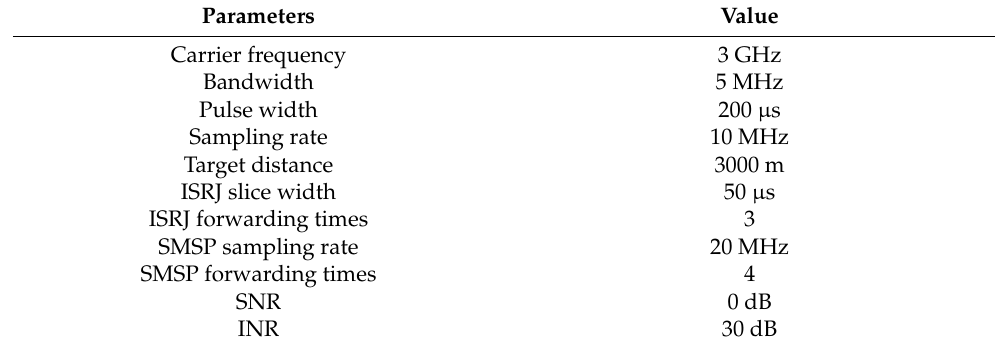
Table 1. Simulation parameters.